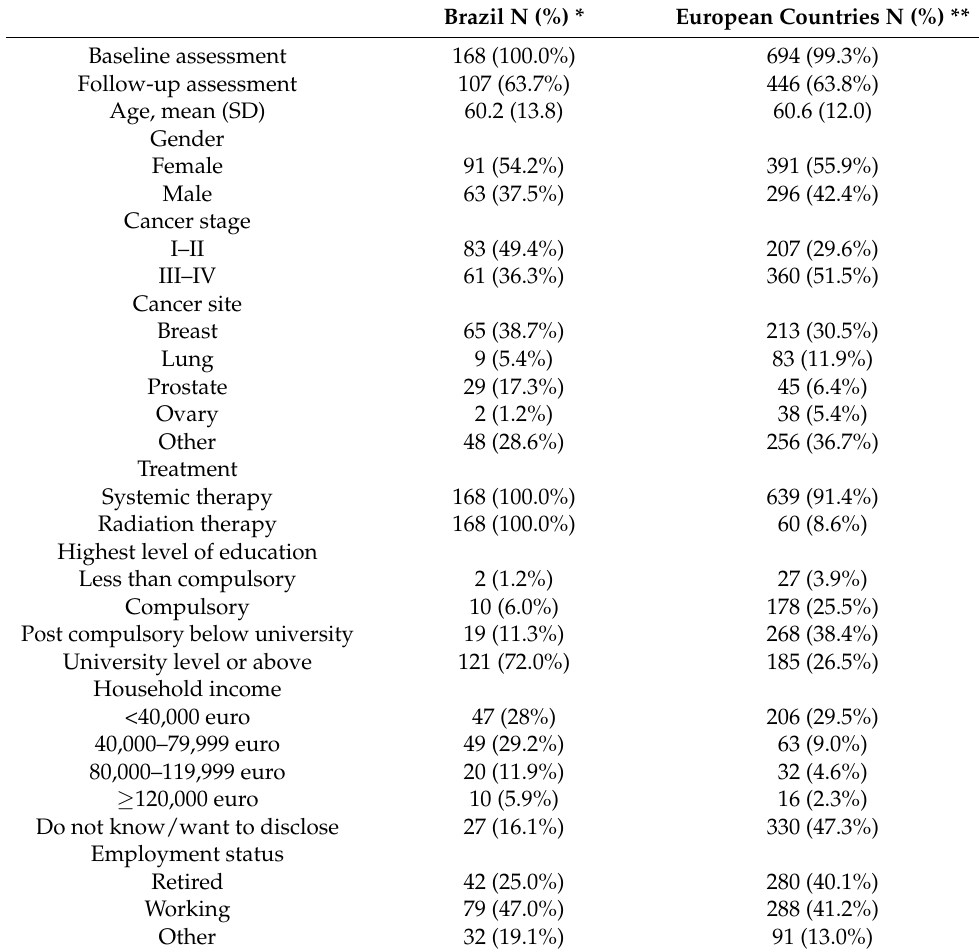
Table 2. Clinical and sociodemographic characteristics at baseline of the included patients (Brazil) and for comparison in the original European validation